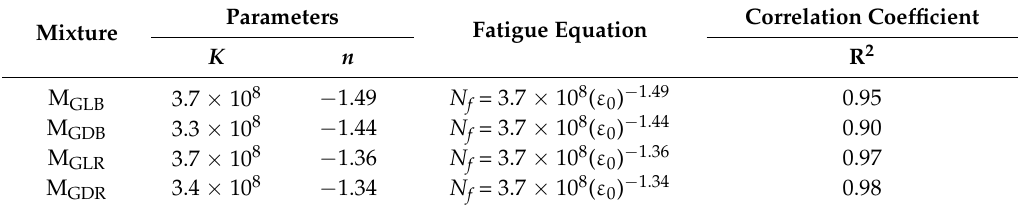
Table 7. Fatigue equations of different asphalt